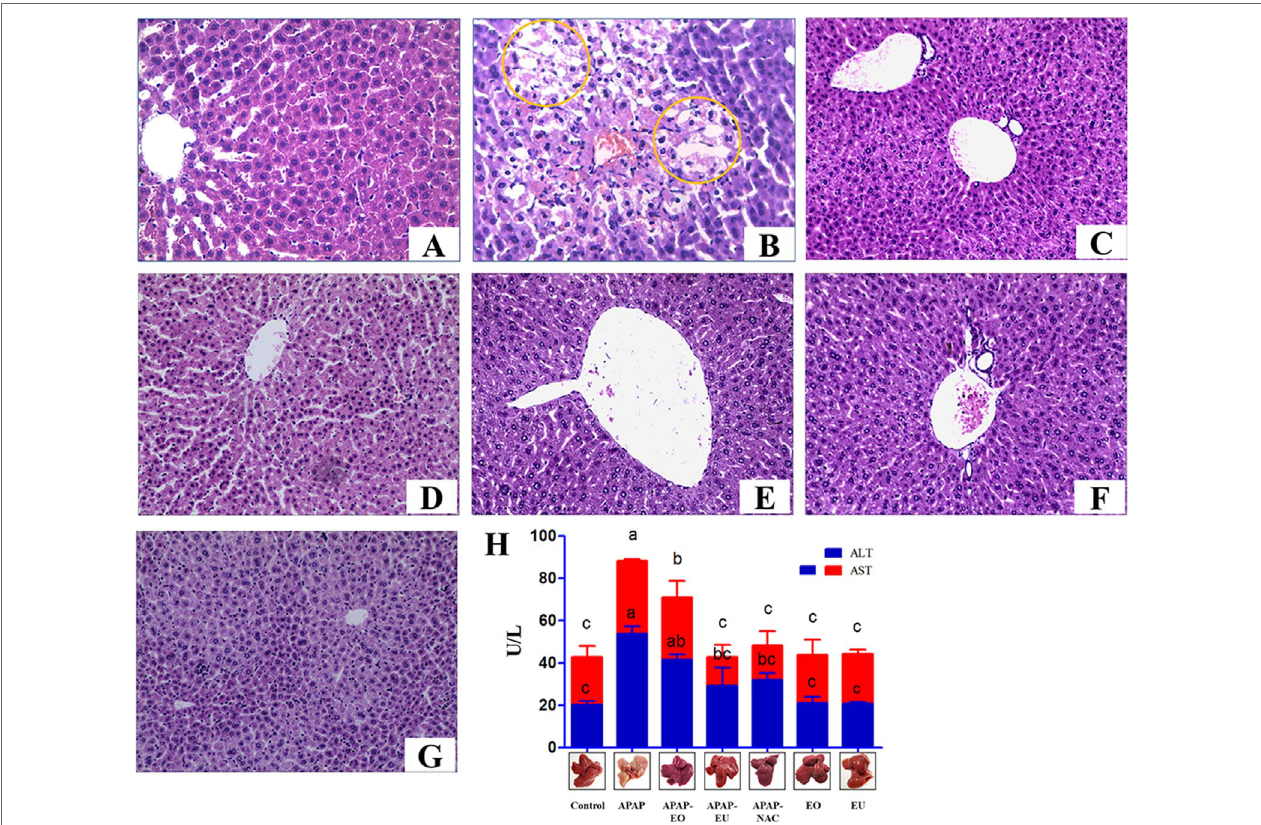
FIGURE 3 | Effect of essential oil and eucalyptol on the acetaminophen (APAP)-induced liver changes and serum biomarkers of liver toxicity in mice. (A–E) The liver changes in mice. (A) Control group; (B) APAP treatment group, circle means cytoplasmic vacuolation; (C) APAP-EO treatment group; (D) APAP-EU treatment group; (E) APAP-NAC treatment group; (F) EO treatment group; (G) EU treatment group; (H) the activity of ALT and AST. n = 6, bars that do not share a common letter (a, b, c) were considered significantly different from each other ( p <